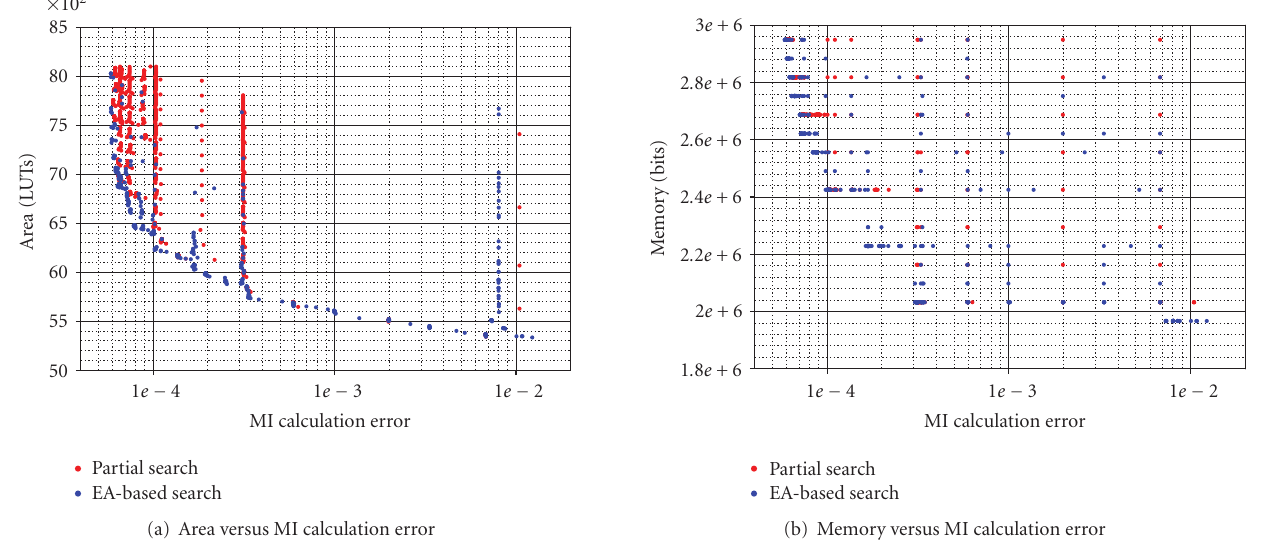
Figure 6: Qualitative comparison of solutions found by partial search and EA-based